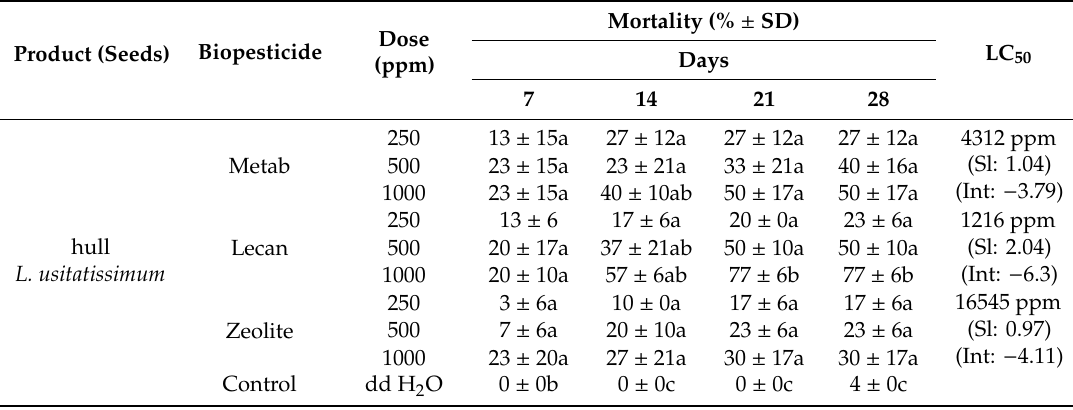
Table 2. Mean mortality (% ± SD) and median lethal concentration (LC 50 with Slope (Sl) and Intercept (Int) values) of T. confusum adults, exposed for 28 days to hull L. usitatissimum seeds that had been treated with Metab, Lecan and Zeolite, at three dose rates. Mean ± SD values with the same letter within a column are not significantly di ff erent ( p < 0.05) ( F = 1.699, df = 6.96, p =